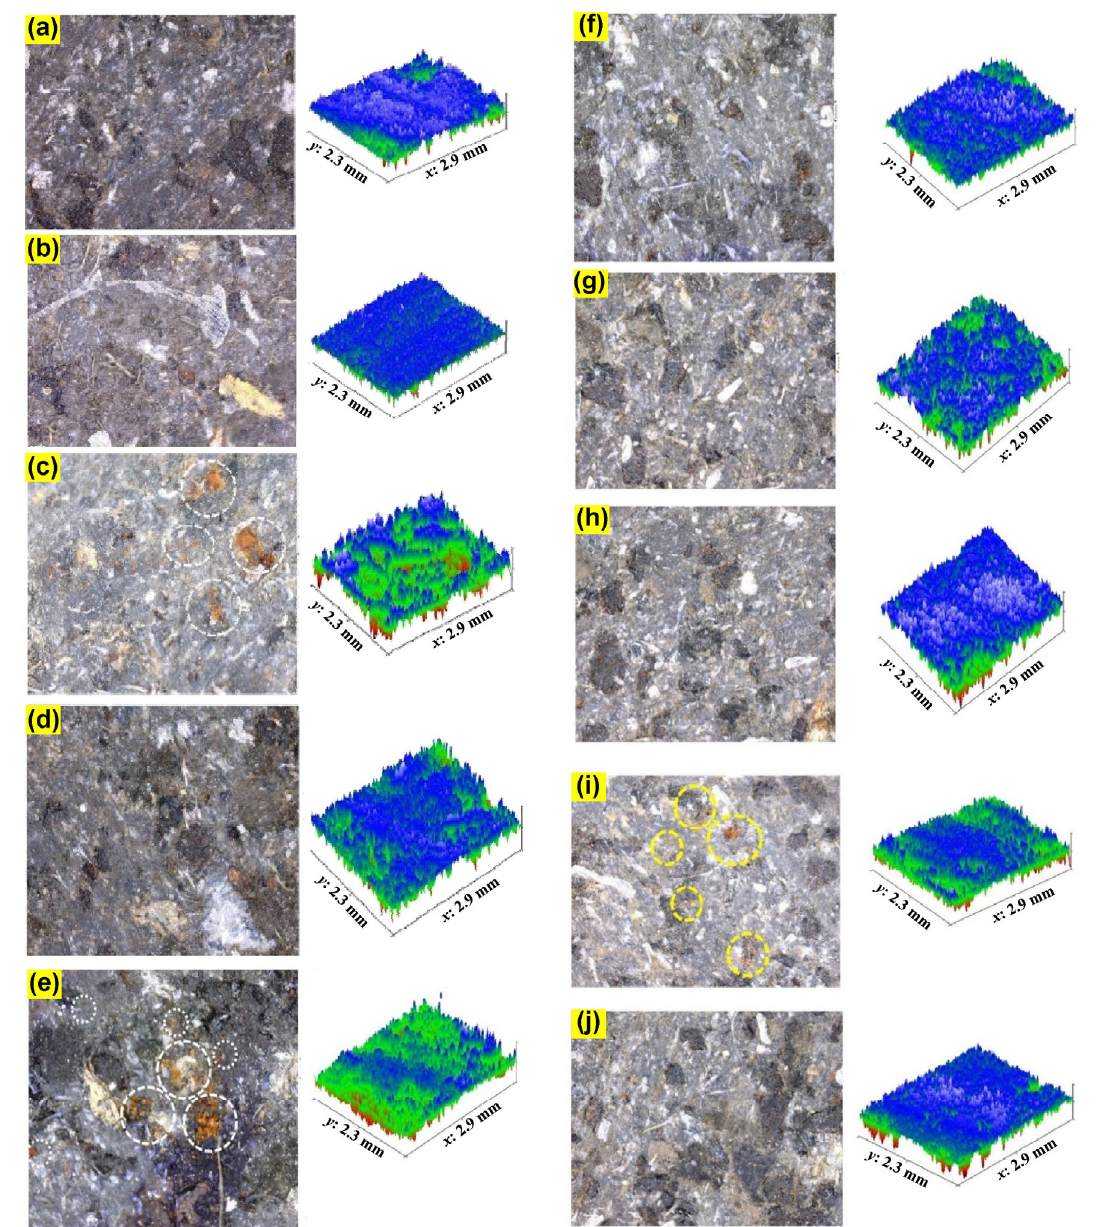
Fig. 15 Microscopic and 3D surface profiles of (a) virgin FM01 sample, (b) virgin FM02 sample, (c) normal water tested FM01 sample, (d) normal water tested FM02 sample, (e) NaCl solution tested FM01 sample, (f) NaCl solution tested FM02 sample, (g) brake oil tested FM01 sample, (h) brake oil tested FM02 sample, (i) humidity tested FM01 sample, and (j) humidity tested FM02